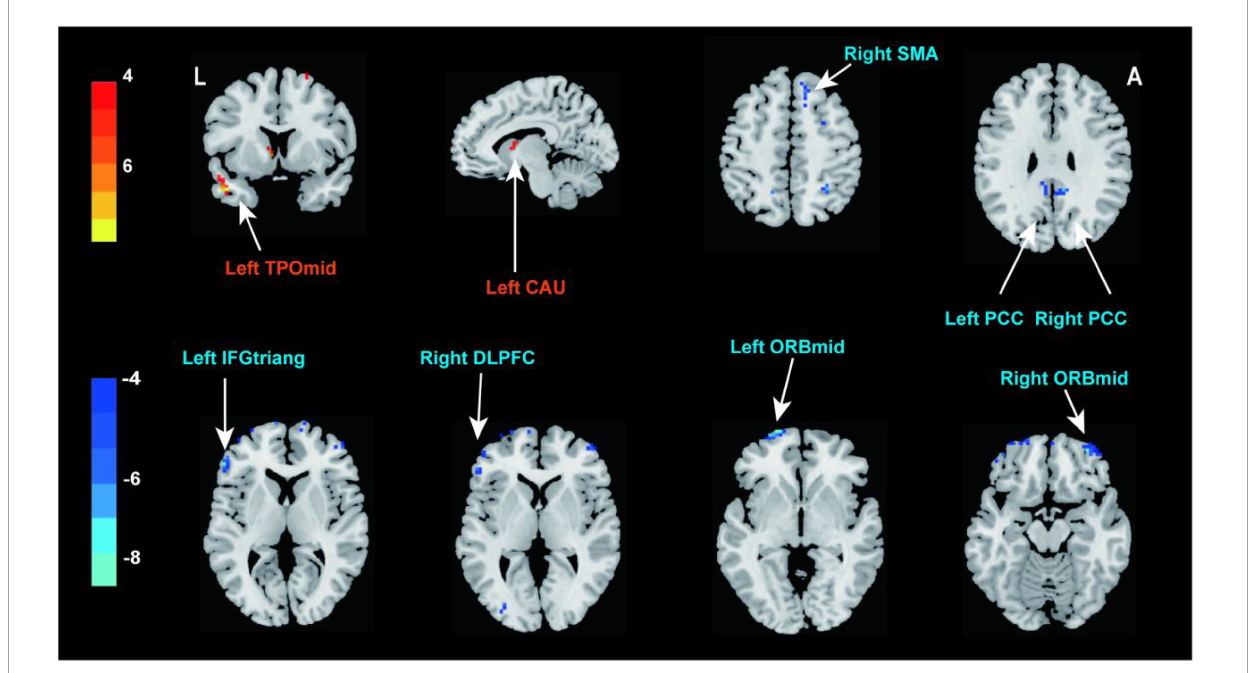
FIGURE4 Brain responses to electroacupuncture treatment ( P < 0.05, FDR correction). Warm color represents an increase and cool color represents a decrease, respectively. TPOmid, middle temporal gyrus; CAU, caudate nucleus; SMA, supplementary motor area; PCC, posterior cingulate cortex; IFGtriang, triangular part of inferior frontal gyrus; DLPFC, dorsolateral prefrontal cortex; ORBmid, orbital part of middle frontal gyrus.